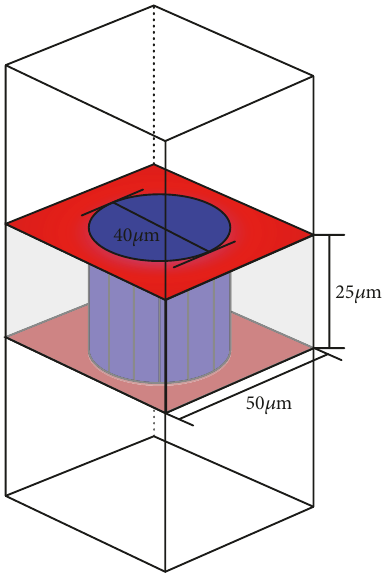
Figure 10: A unit cell of photonic crystal structure for numerical simulation.